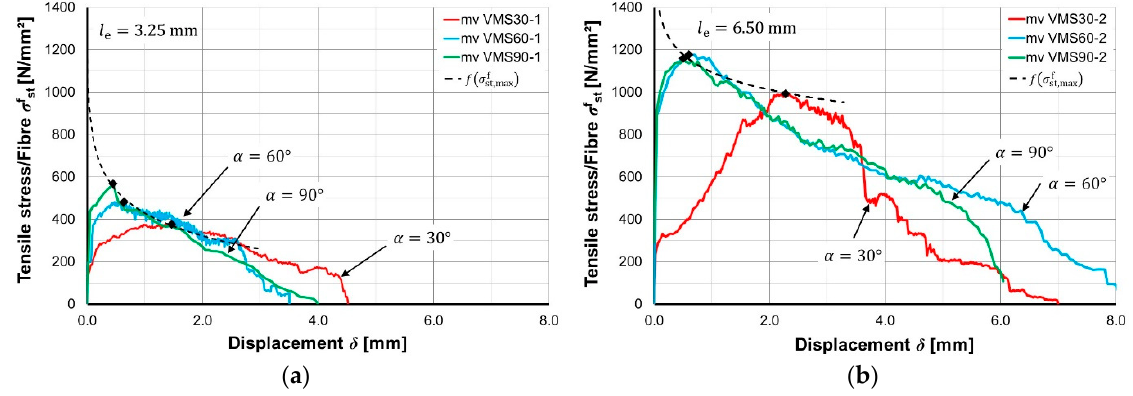
Figure 8. Pullout behaviour (tensile stress displacement curves) of steel fibre from UHPC under monotonic loading for an embedded length of 𝑙 f /4 ( a ) and 𝑙 f /2 ( b ).